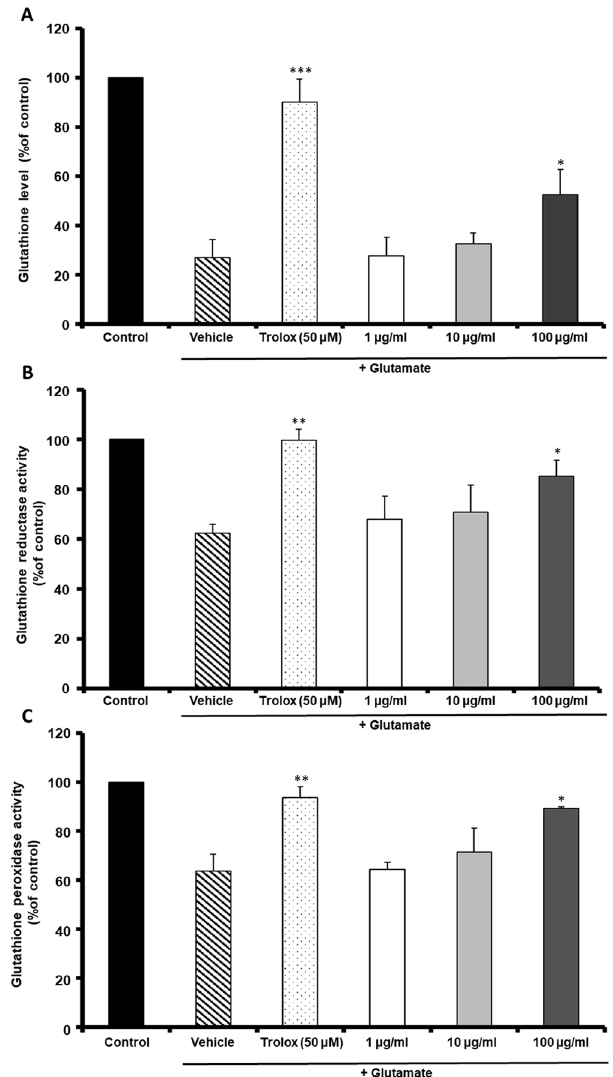
Figure 5. The effect of MF extract on glutathione (GSH) ( A ), glutathione reductase (GR) ( B ) and glutathione peroxidase (GPx) ( C ) activities in HT22 cells. Results are expressed as percentages of the values of control cells. * p < 0.05, ** p < 0.01 and *** p < 0.001 vs. glutamate-treated